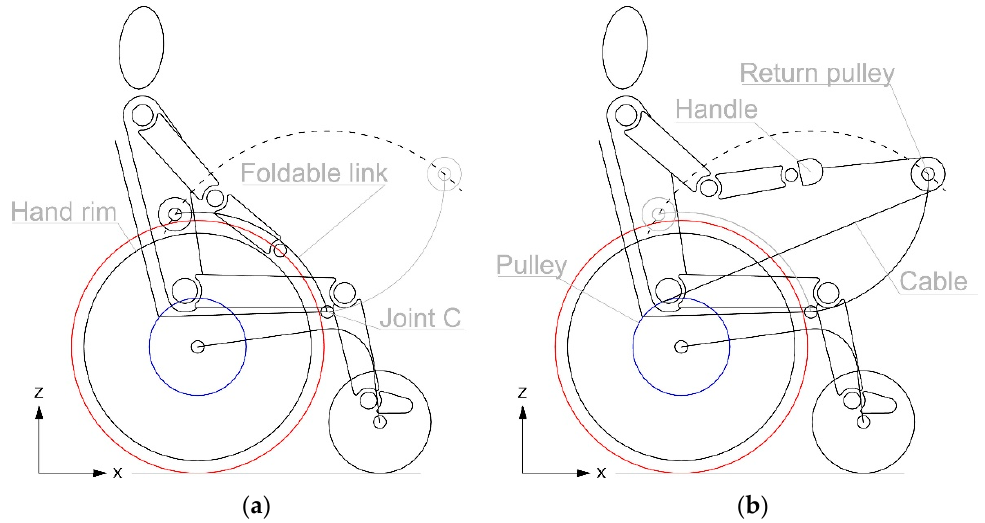
Figure 6. ( a ) Handwheelchair.q02 indoor configuration; ( b ) Handwheelchair.q02 outdoor configuration.